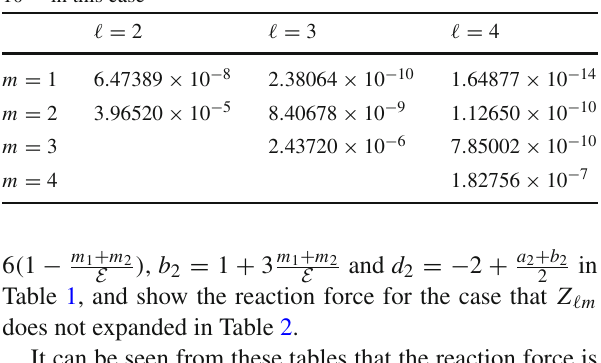
Table 2 The reaction force for different (cid:7) , m modes for Z (cid:7) m does not expanded in the EOB theory, the total reactionforce F circ ϕ = 4 . 23409 ×